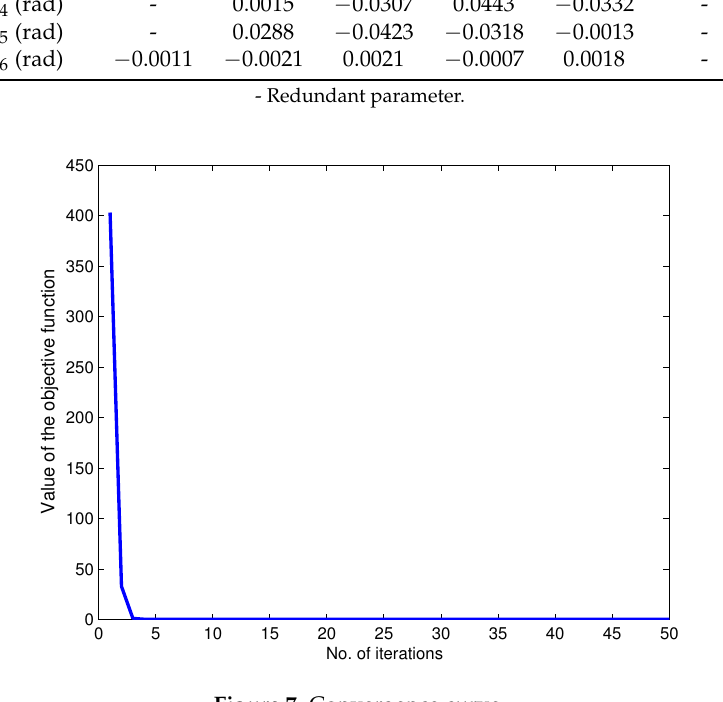
Figure 7. Convergence curve.